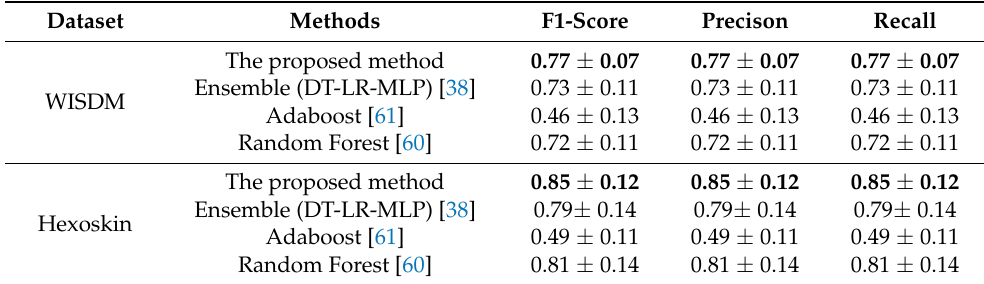
Table 5. Comparison with state-of-the-art ensemble learning techniques applied to the WISDM and Hexoskin